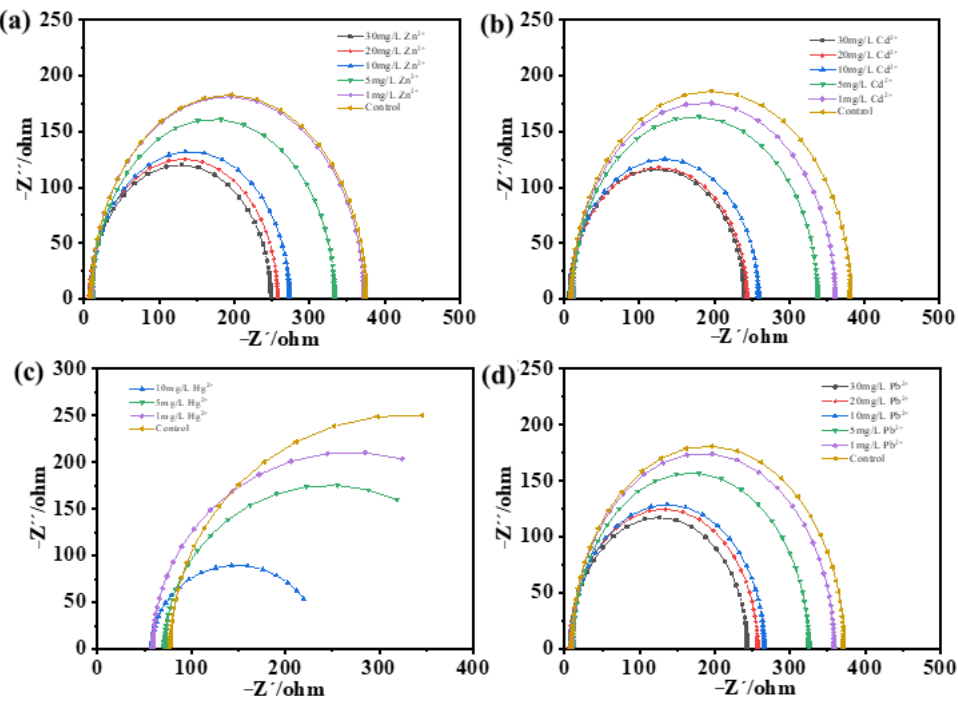
Biosensors 2023 , 13 , x FOR PEER REVIEW Figure 5. The EIS spectrum of the SMFCs after the detection of Cd 2+ ( a ), Zn 2+ ( b ), Hg 2+ ( c ), or Pb 2+ ( d ).